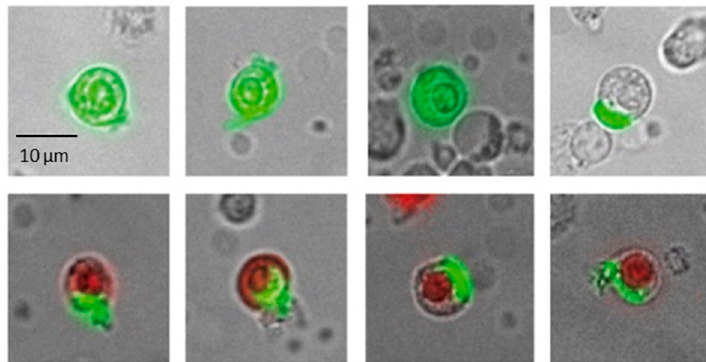
Figure 1. Typical gallery of images of live (EpCAM fluorescein-isothiocyanate (FITC) green) and dead (green and red Propidium Iodide Uptake) tumor suspect cells of one patient. Dead cells are not included into the cell count.